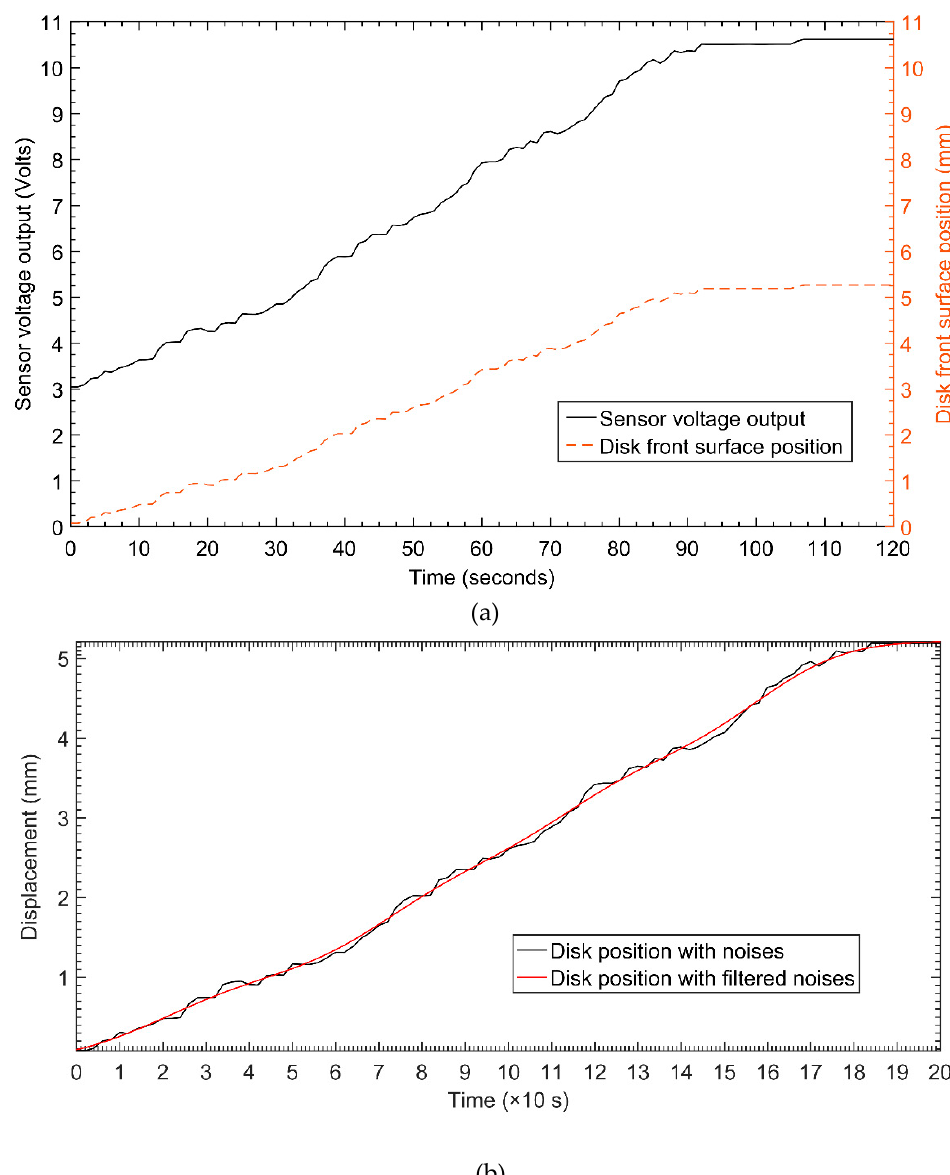
Figure 11. ( a ) Signals of disk front surface position in front of inductive sensor before filtering, in voltage units form and in distance units. ( b ) Disk front surface position measurement with noises and without noises .